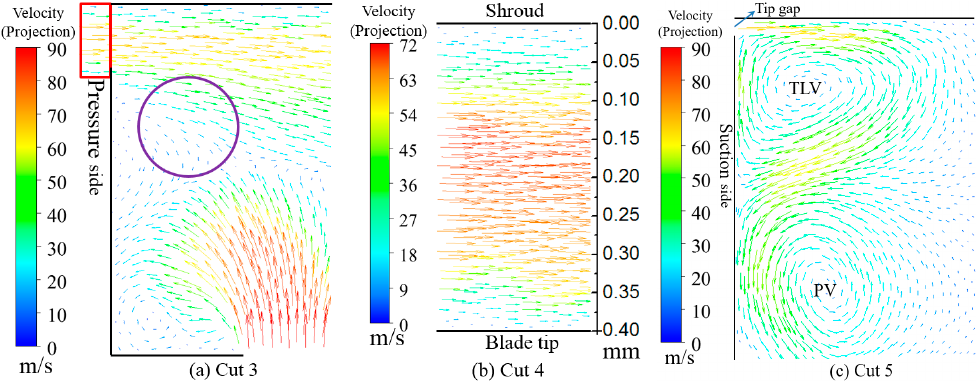
Figure 11. Velocity vectors at the BR of 1.5 and rotation rate of 2500 r/min in BSSS case after modification using h s = 0.04 mm: ( a ) Cut 3; ( b ) Cut 4; ( c ) Cut 5.